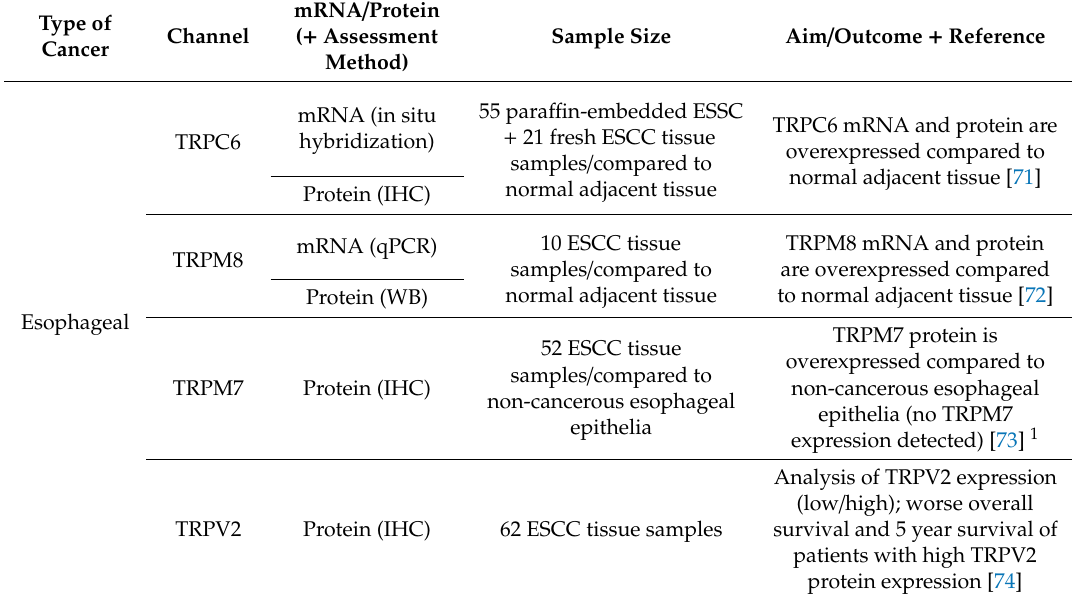
Table 2. Expression of TRP channels in human esophageal squamous cell carcinoma